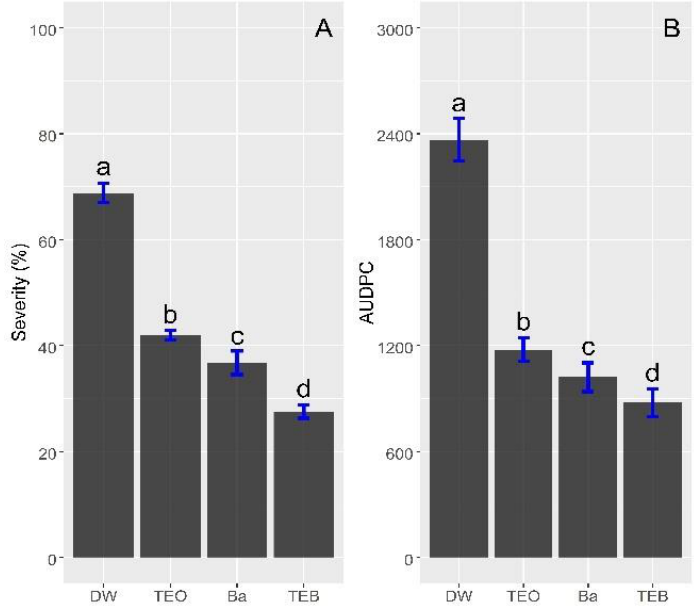
Figure 6. ( A ) Final disease severity (disease index) of tomato early blight caused by Alternaria linariae at 70 days after inoculation. Bars followed by different letters differ from each other by the Scott–Knott test ( p ≤ 0.05). ( B ) Area under the disease progress curve (AUDPC). Mean AUDPC values are the result of the cumulative disease index. Treatments: DW: distilled water; TEO: thyme essential oil; Ba: Bacillus amyloliquefaciens MBI600; and TEB: tebuconazole. Bars with different letters are significantly different from each other according to the Scott–Knott test ( p ≤